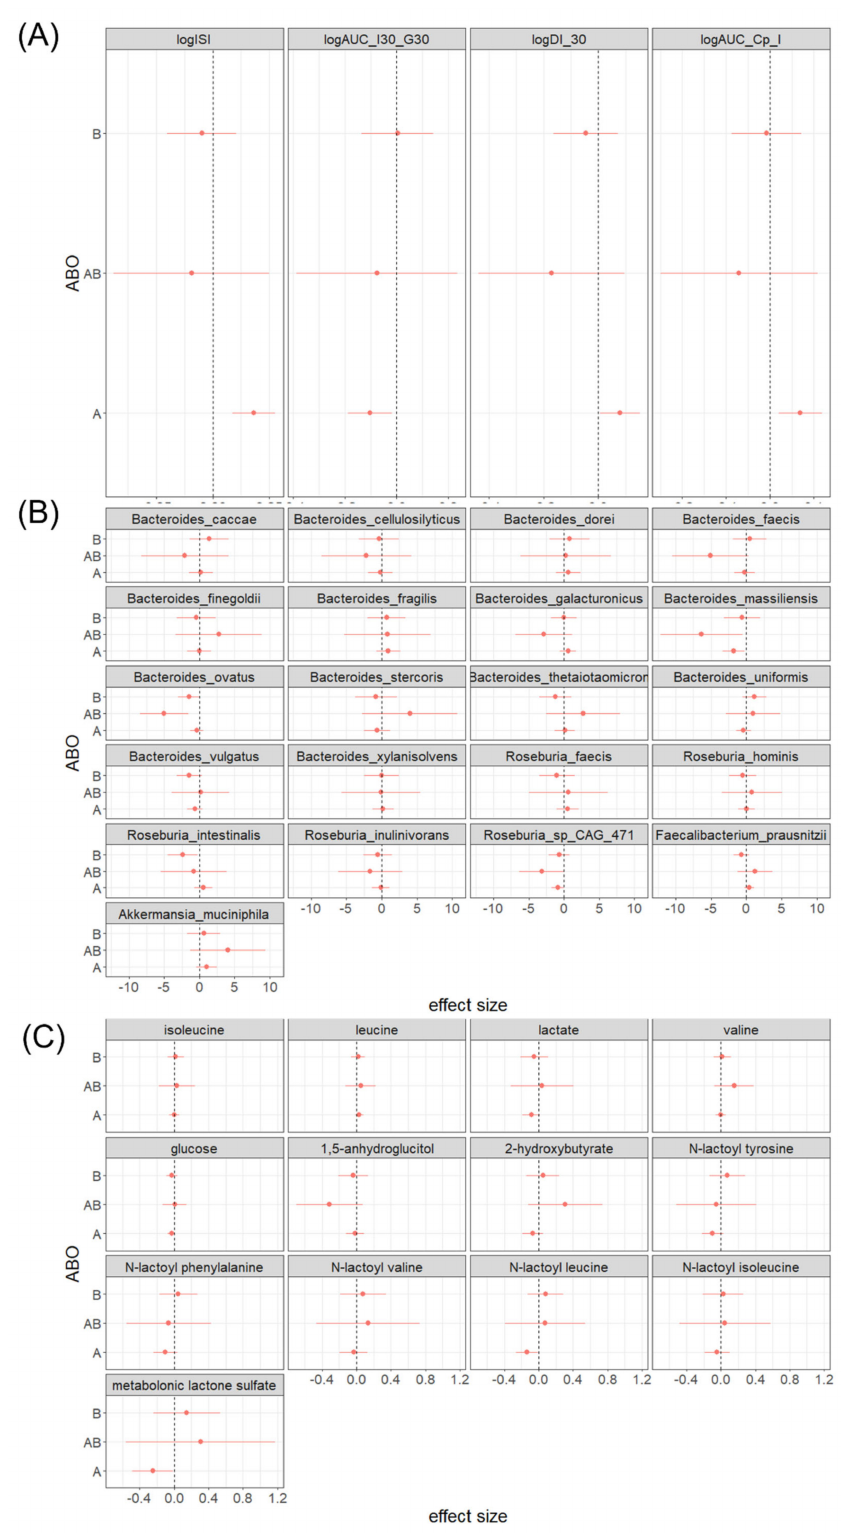
Figure 2. The associations between ABO blood group and ( A ) insulin-related traits, ( B ) relative abundance of selected species as well as ( C ) selected diabetes-associated metabolites in the white population of the MILES